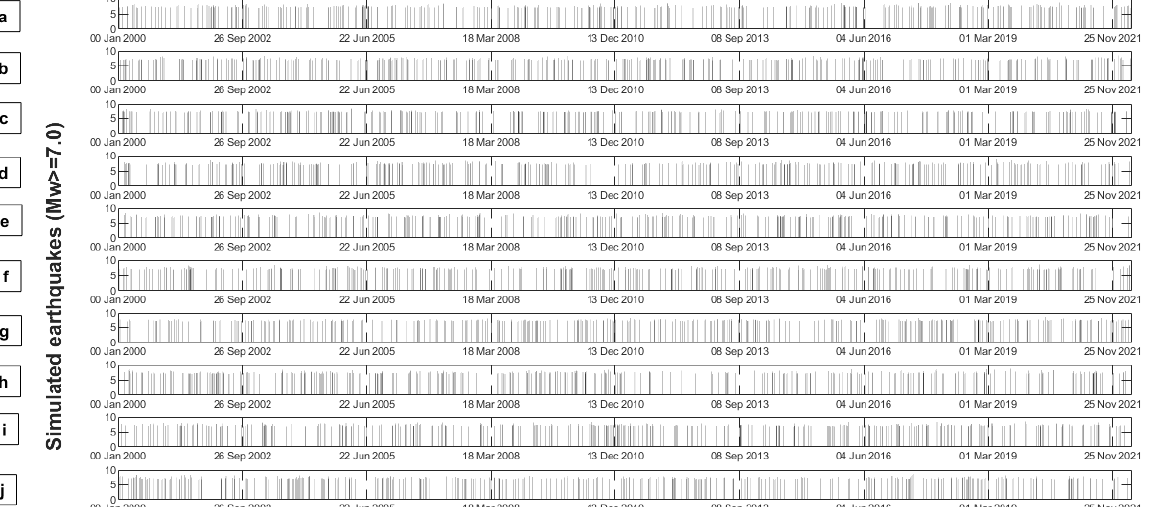
Figure 7. Panels ( a – j ) show the results of 10 simulated earthquakes datasets. The y-axis in each panel indicates the number of simulated earthquakes accompanied by anomalous changes in the Kp index during the days prior to the simulated earthquakes. Median and higher and lower bounds are drawn as green and red horizontal lines, respectively. The allowed ranges are defined as M ± 1.25 × IQR , in which M and IQR are the median and the inter-quartile range parameters, respectively.